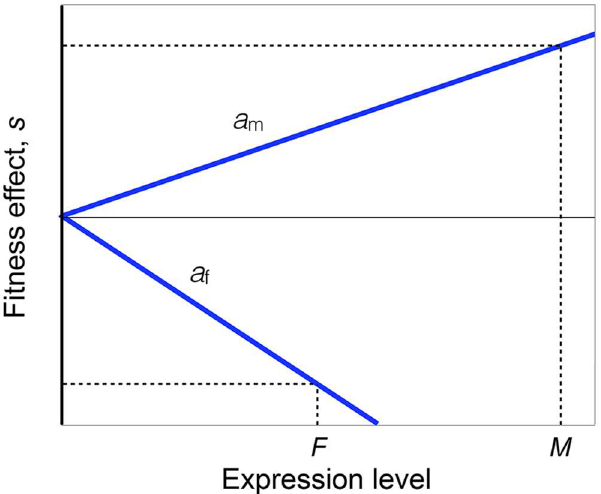
Fig 3. Schematic of the genetic model. The X-axis shows the expression of a locus, measuredas the log of the numberof transcripts, in males ( M )and females ( F ). The Y-axis shows the additive fitnesseffect of an allele in males ( s m ) and females ( s f ). No selection( s m , s f = 0) occurs when thereis no expression ( M , F = 0). Fitnesseffects increasewith expression at a rate a m in males and a f in females. At an evolutionary equilibrium, s m = – s f . Our measure Δ of sex-bias is approximately equal to twice the difference between M and F , normalized by the total of expression in both sexes, M + F , when Δ is small.Furtherdetailsare given in the Materialsand